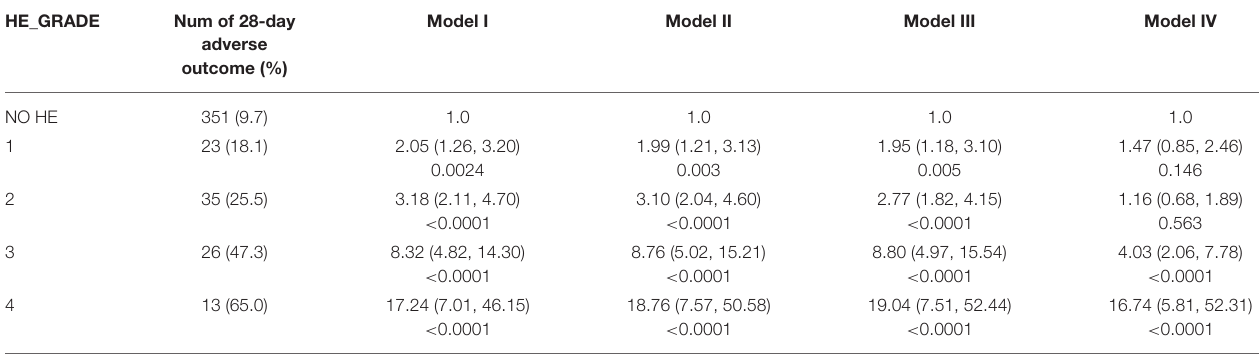
Model I, unadjusted. Model II, adjusted for age, sex, and etiology.